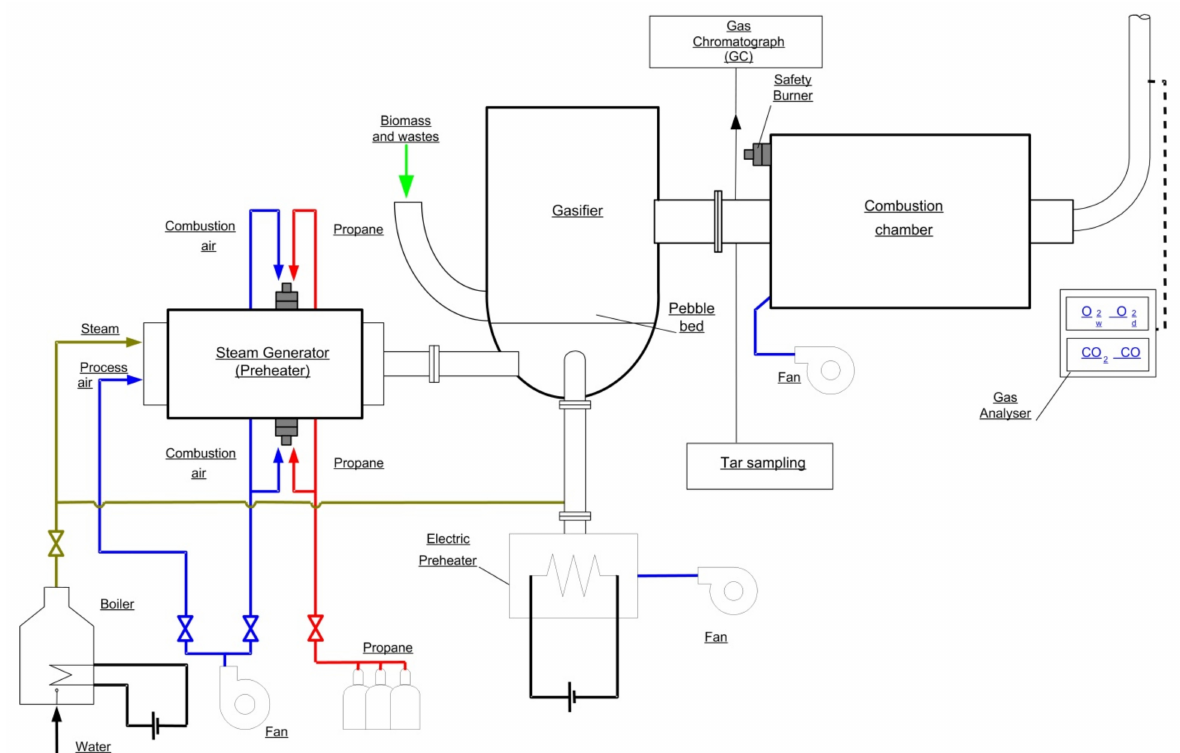
Figure 1. High Temperature Air/Steam Gasification test facility (laboratory scale).